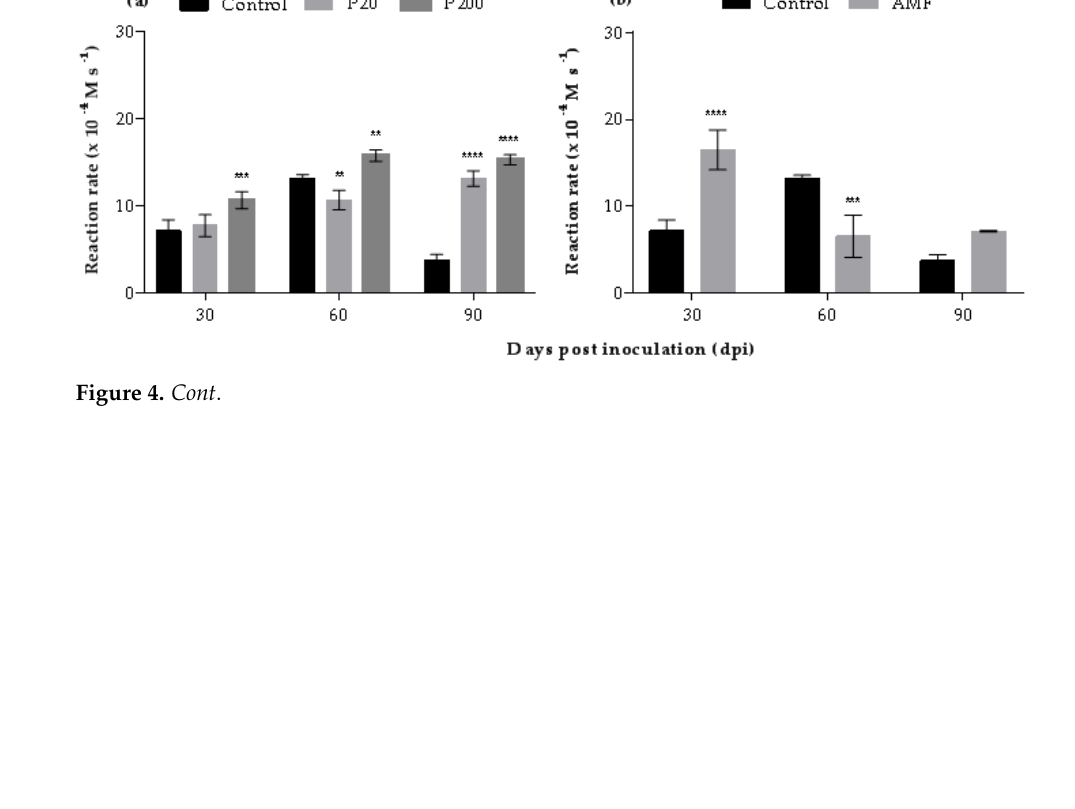
Figure 4. Variation in lipoxygenase activity in P. divaricatum : ( a ) plants treated with 20 and 200 mg of P·dm − 3 of soil (P20 and P200); ( b ) plants inoculated with AMFs (AMF); ( c ) plants inoculated with AMFs and treated with 20 and 200 mg of P·dm − 3 of soil (P20 + AMF and P200 + AMF). Statistical difference according to Bonferroni test ( p < 0.05). Significance level: **** extremely significant ( p < 0.0001), *** very significant ( p < 0.001), ** low significant ( p < 0.01) . 3.5. Phenylalanine Ammonia Lyase (PAL) The influence of P addition and inoculation by AMF on enzymatic activity of phenylalanine ammonia-lyase was quantified. Plants treated only with P or AMF did not display variation in PAL activity (Figure 5a,b). However, at 90 dpi in the P20 + AMF group, there was a decrease of 24% (28.25–21.35 μ U mL − 1 ) compared to the control group. On the other hand, the P200 + AMF group had 15% increased PAL activity (28.25–32.49 μ U mL − 1 ) compared to the control group (Figure 5c).